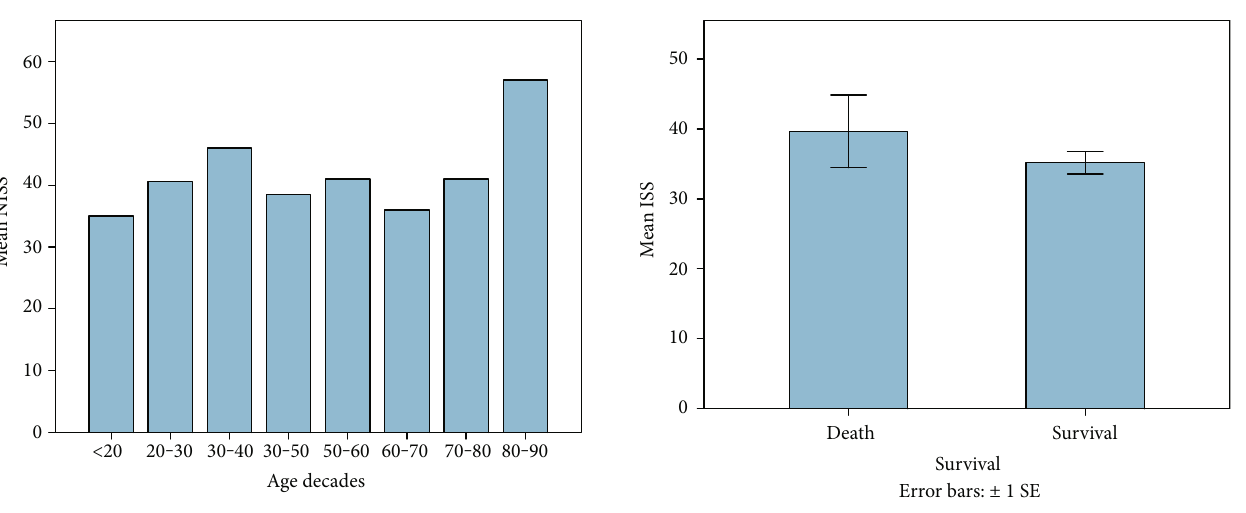
Figure 4: Mean ISS of all patients correlated to patient ’ s outcome. Patients who died after the traumatic event showed higher mean ISS than those who survived (mean ISS survivors: 35 ± 11 : 6 SD; mean ISS nonsurvivors: 39 : 3 ± 12 : 2 SD).